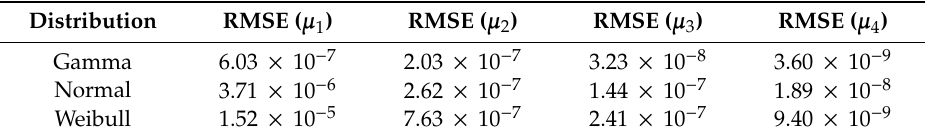
Figure 2. Probability-density functions of fitted distributions. Table 2. Root mean squared errors (RMSEs) of moments of fitted distributions. Table 2. Root mean squared errors (RMSEs) of moments of fitted distributions.